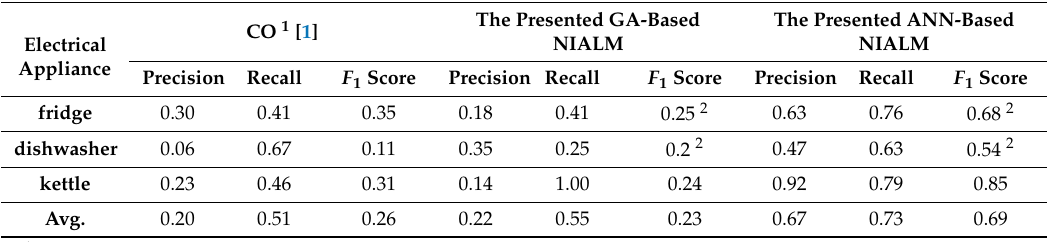
Table 7. Comparison among the CO, the parallel computing accelerated GA and the feed-forward, multilayer ANN for load